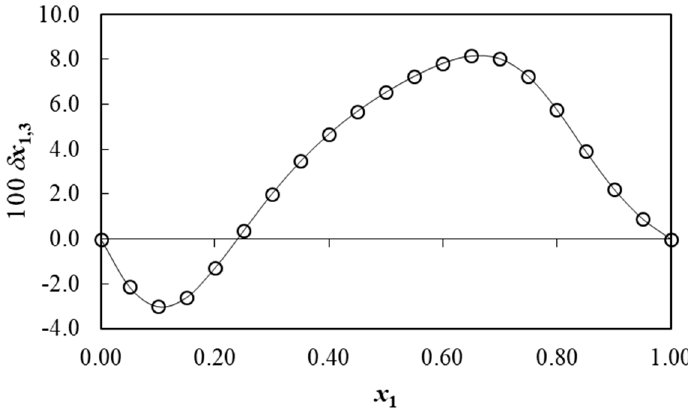
Figure 6. Preferential solvation parameters ( δ x 1,3 ) of benzoic acid ( ○ ) by ethanol in {ethanol (1) + water (2)} mixtures at T = 298.15 K.